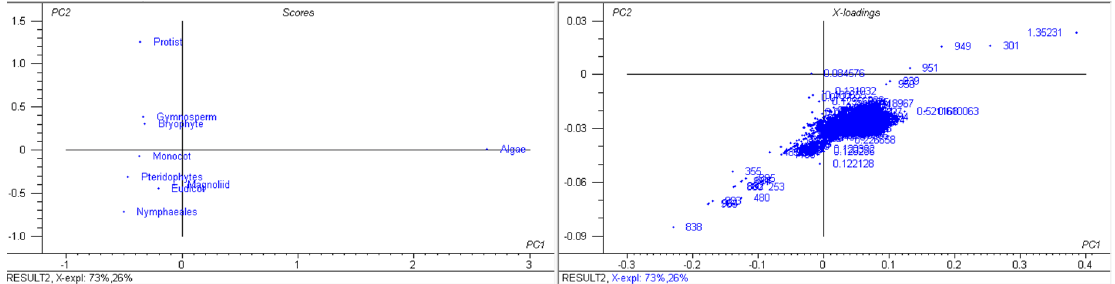
Figure 2. Principal component analysis of chloroplast genome sizes. The genome size of gymnosperms and bryophytes fall in one group and eudicots, magnoliids, monocots, and pteridophytes fall in the other group; however, algae and protists fall distantly. The number of coding sequences (CDS) in the analyzed chloroplast genomes ranged from 273 ( Pinus koraiensis and Choreocolax polysiphoniae ) to 3 ( Pilostyles aethiopica ; Figure 1). The average number